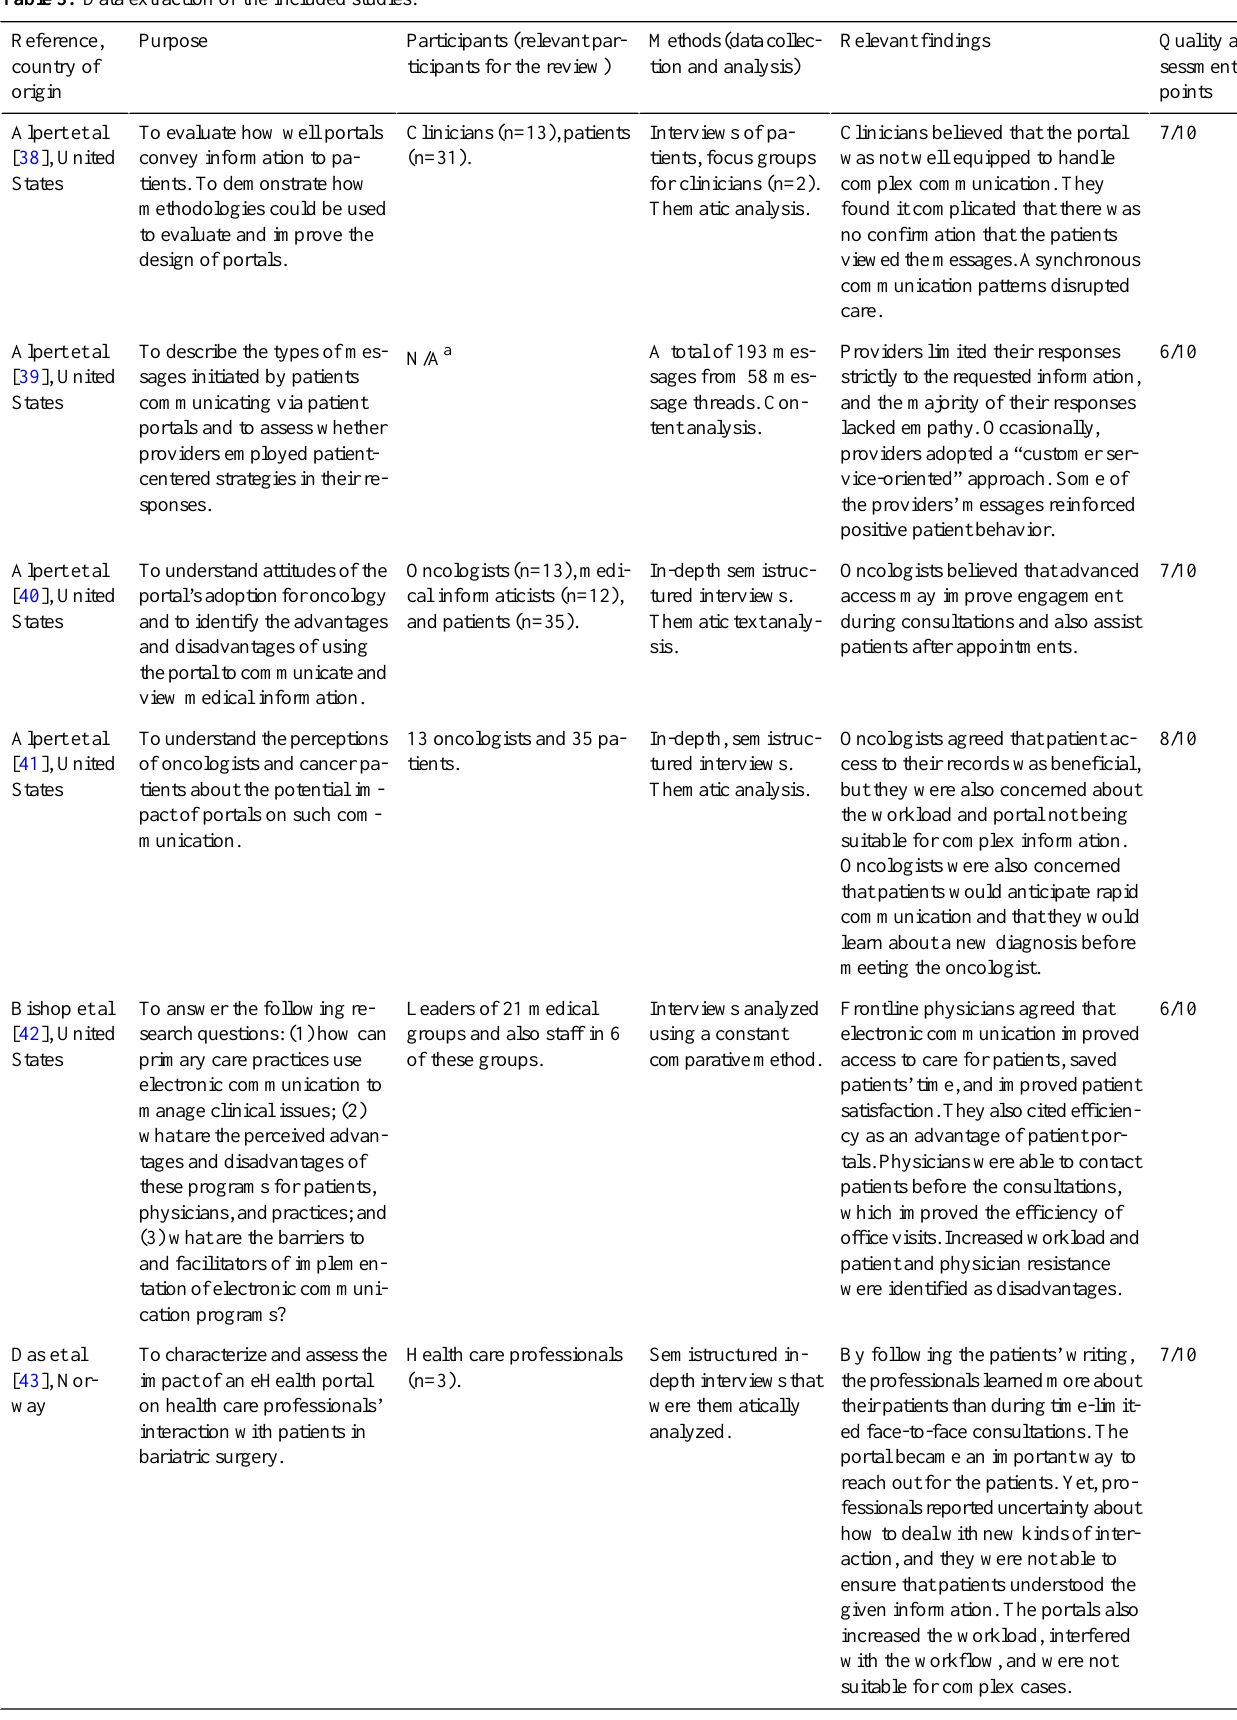
Table 3. Data extraction of the included studies.